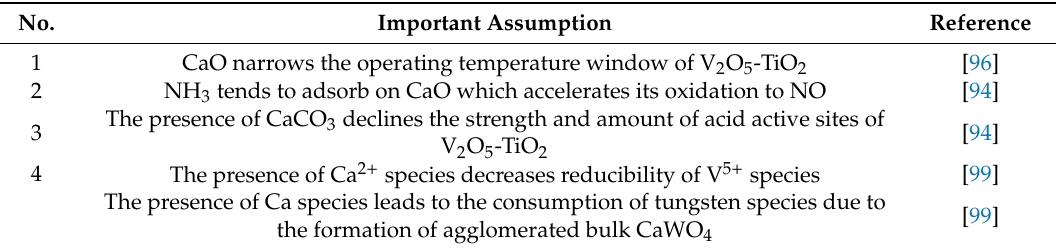
Table 4. The most important findings on the interaction of calcium with V 2 O 5 -TiO 2